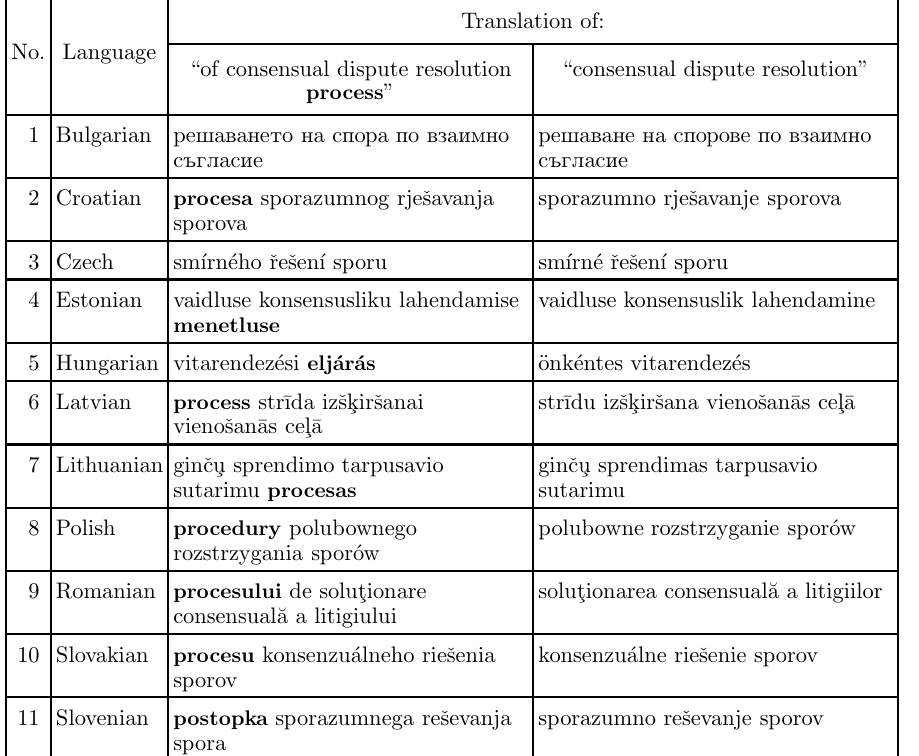
Table 2 English phrase “of consensual dispute resolution process” translated into CEE languages Translation